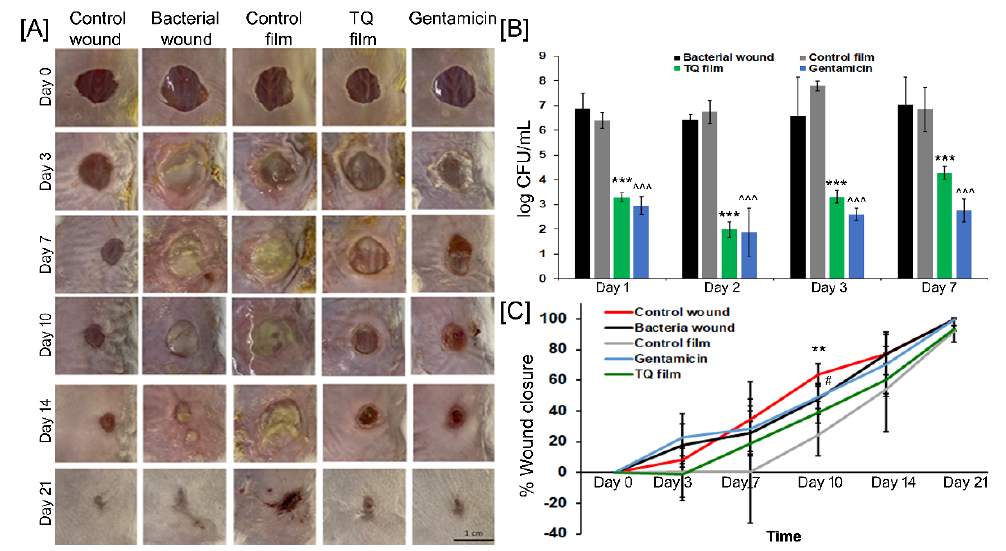
Figure 8. Antibacterial effects of TQ films on full-thickness skin wounds infected with S. aureus . ( A ) Photographs of skin wounds with different treatments over 21 days. The wounds were infected with bacteria as shown above as a pale biofilm in the bacteria wound group and other related groups. Scale bar = 1 cm. ( B ) Log of bacterial reduction at each timepoint up to 7 days assessed in di ff erent experimental groups. *** p < 0.001 (Bacterial wound vs. TQ Film) and ˆˆˆ p < 0.001 (Bacterial wound vs. Gentamicin). ( C ) Percentage of wound closure as a function of time in all experimental groups at di ff erent time points post-wounding and treatments. ** p < 0.01 (Control wound vs. Control Film) and # p < 0.05 (Control Film vs.